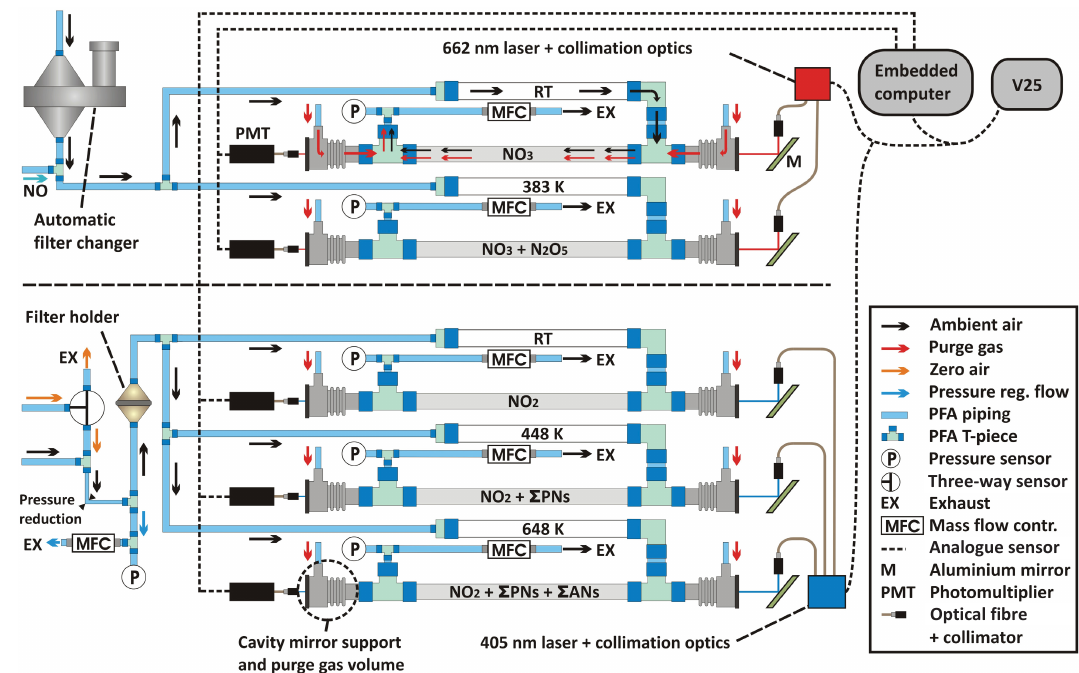
Figure 2. Schematic of the five-channel TD-CRDS. Gas flows are represented by coloured arrows. The wall temperatures of the different inlets are given for each channel. RT: room